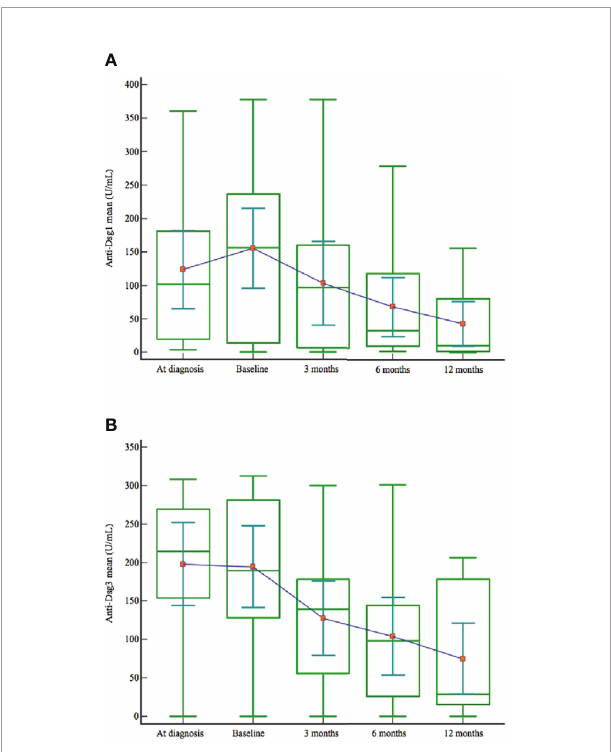
FIGURE 2 | Anti-Dsg 1 (A) and anti-Dsg 3 (B) mean values at the diagnosis, before the start of retuximab and at months 3, 6 and 12 after rituximab treatment.